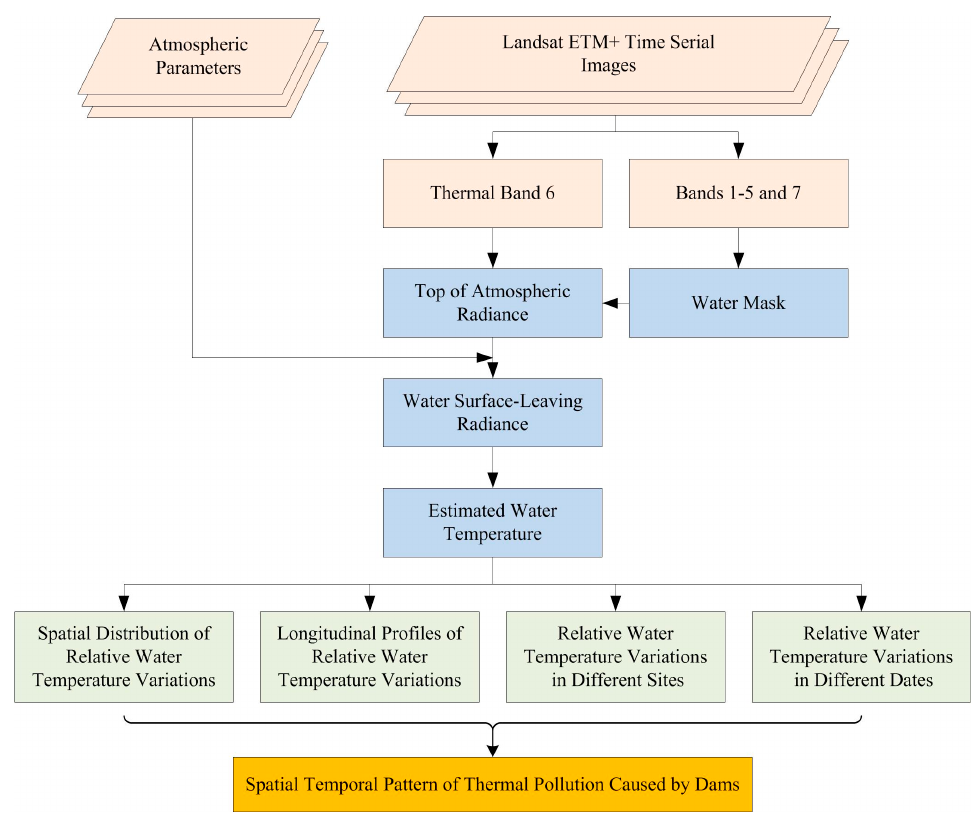
Figure 5. Flowchart for monitoring thermal pollution downstream of dams with Landsat ETM+ thermal infrared images.